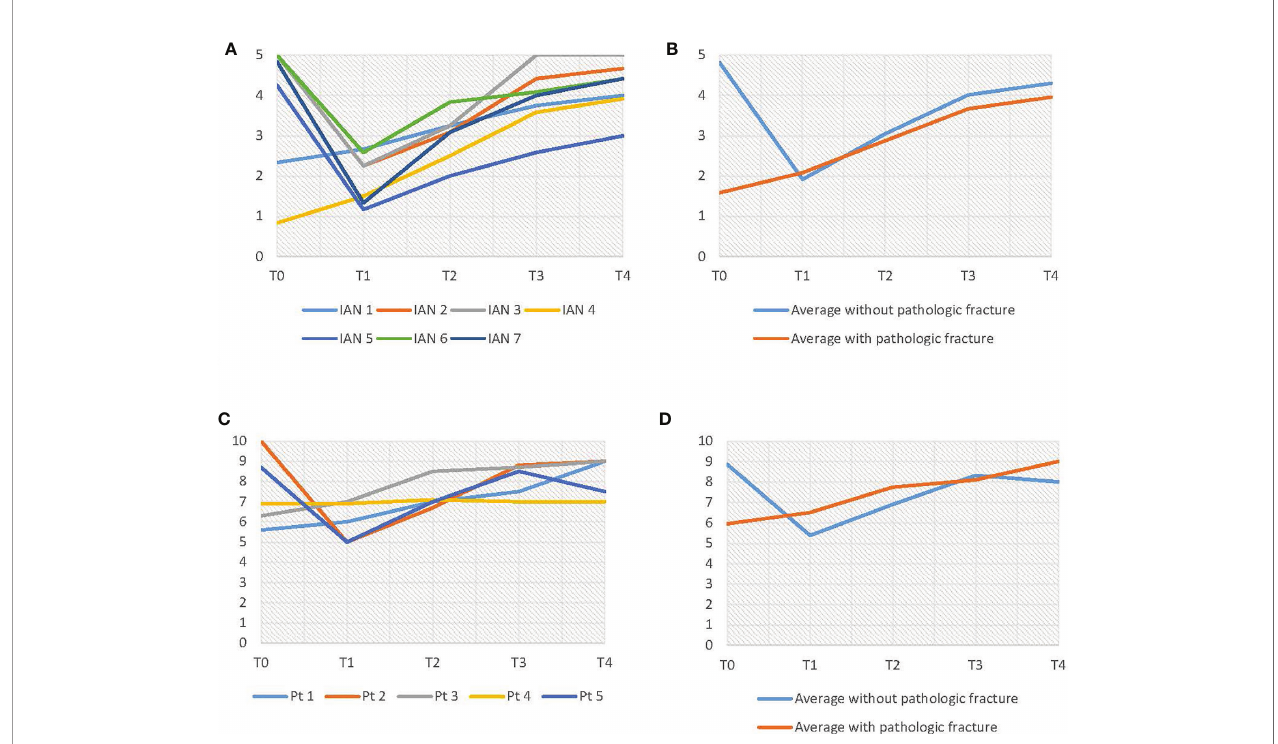
FIGURE 8 | (A) Results of the light touch test. (B) Average results of the light touch test, differentiated on pathologic fracture. (C) VAS-score results. (D) Average VAS-score results, differentiated on pathologic